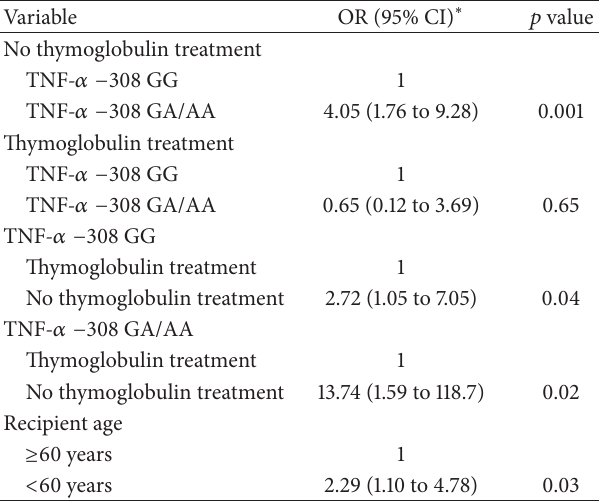
Table 3: Multivariate analysis for acute rejection in the discovery cohort ( 𝑛 = 286 ).